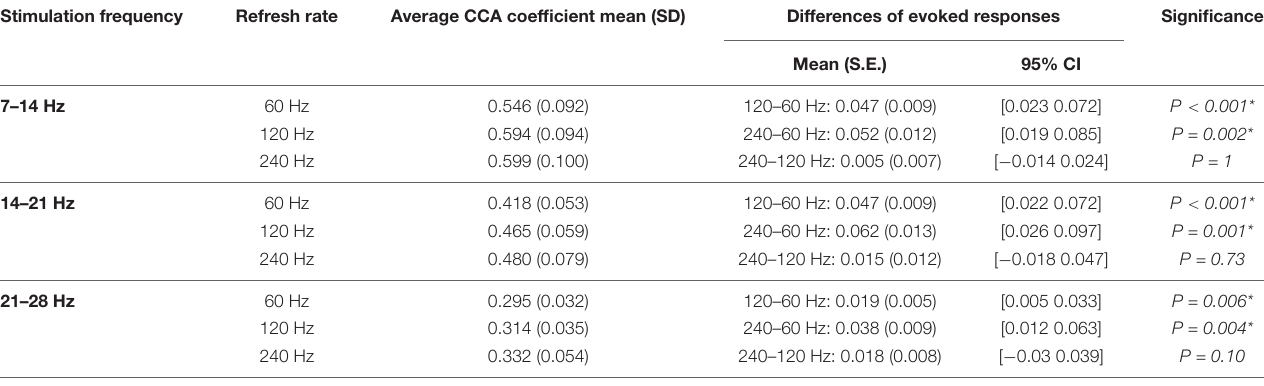
TABLE 1 | The post hoc comparison results of sinusoidal motion stimulation with different refresh rates.